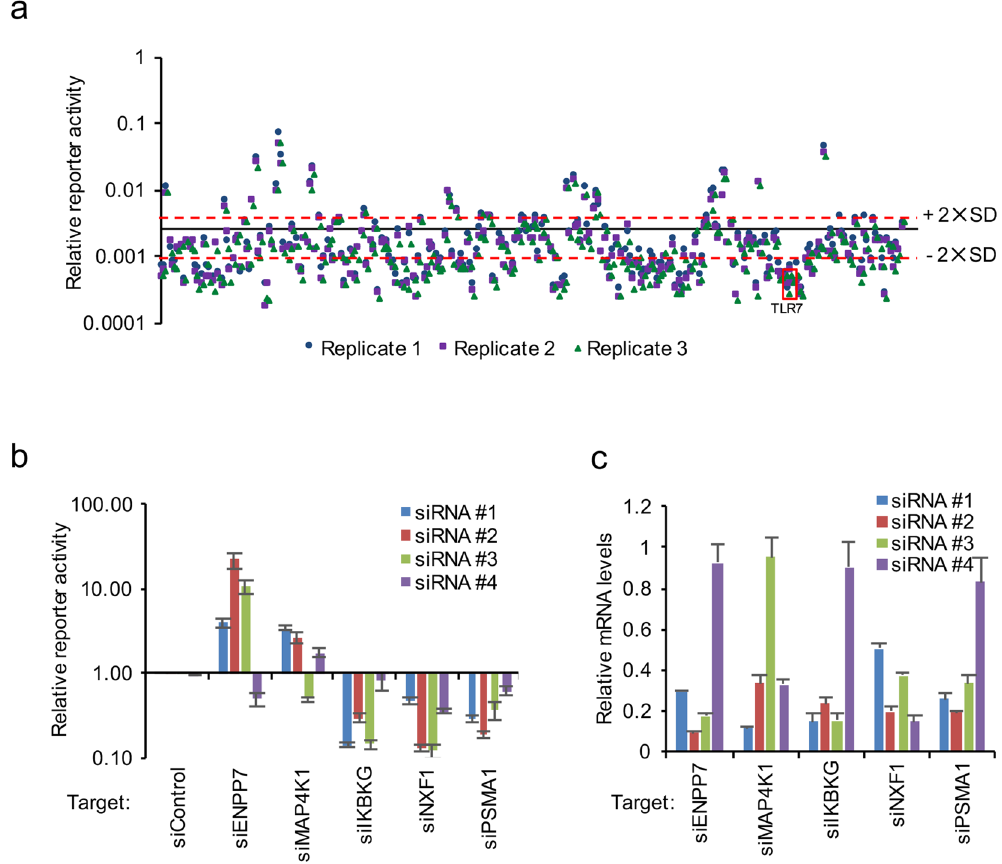
Figure 5. Validation of SMARTpool RNAi screen. ( a ) The hits from SMARTpool RNAi screen were selected for further validation by RNAi using individual siRNA duplexes. Four siRNA pairs per gene were individually transfected into the IRF5 reporter cells followed by treatment with 10 μ g/ml R848 in three independent experiments. Luciferase activities and CellTiter-Glo were measured at 16 hr after R848 stimulation. ± 2 × SD are indicated by red dash lines. The positive siTLR7 controls are boxed. ( b ) Four siRNA duplexes per gene were individually transfected into the IRF5 reporter cells followed by treatment with 10 μ g/ml R848 in three independent experiments. Cell were collected at 16 h after R848 stimulation. Luciferase activities and CellTiter- Glo were measured. ( c ) Four siRNA duplexes per gene were individually transfected into the IRF5 reporter cells. After 72 hr, RNA was extracted for RT-PCR to determine the mRNA expression levels of each target